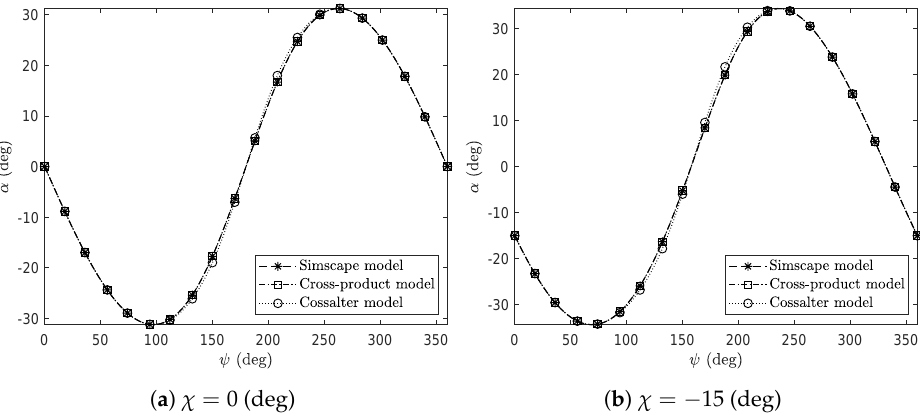
Figure 16. The absolute roll angle of the front assembly or camber angle denoted with α . ( a ) considers the case of a constant roll angle of the rear frame equal to zero. ( b ) presents the case of a constant roll angle of the rear frame equal to χ = − 15